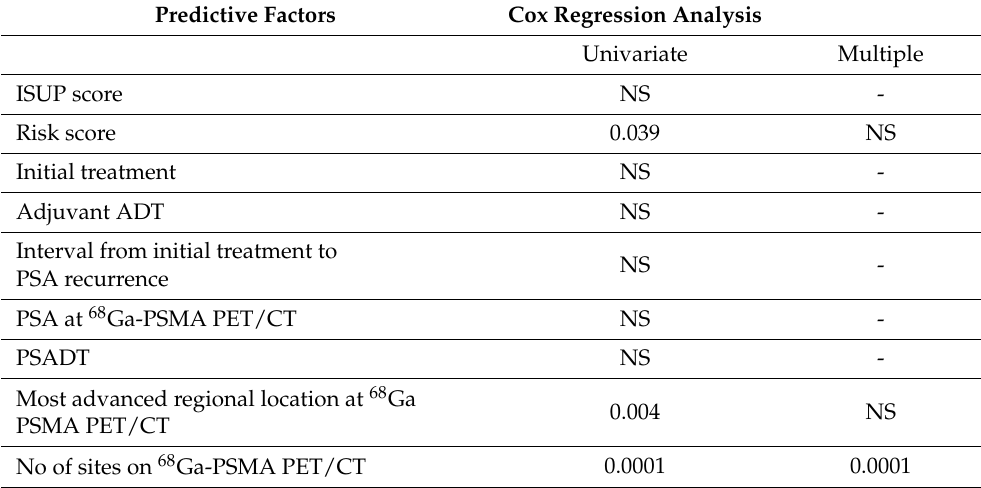
Table 3. Analyses of overall